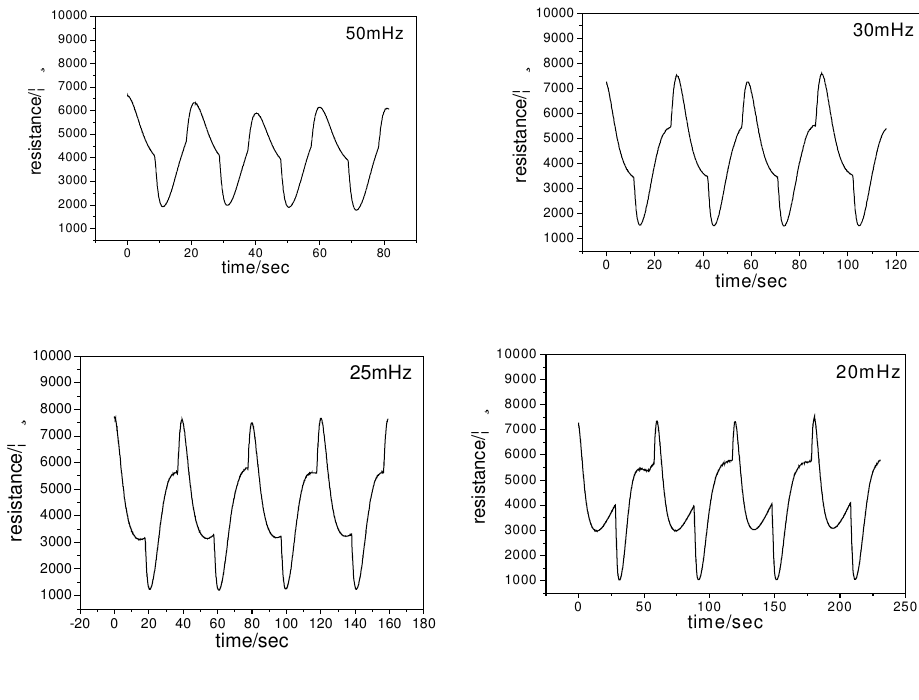
Figure 3. Effect of modulated temperature frequency on the response of 0.1ppm trichlorphon